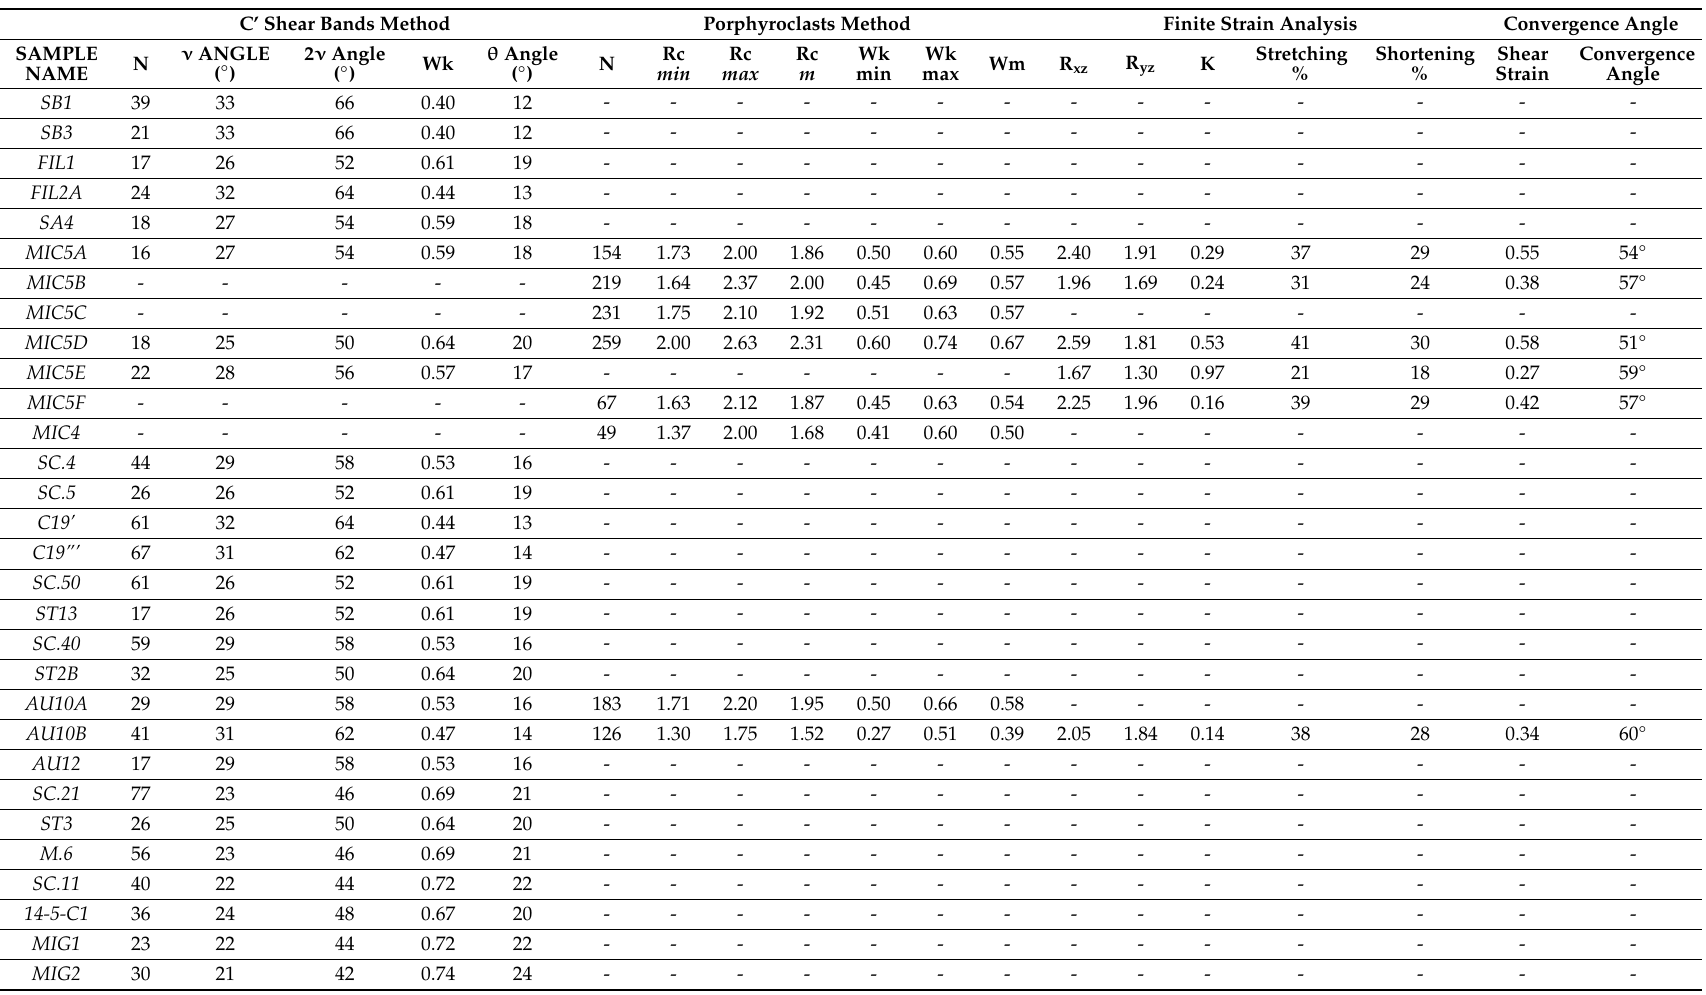
Table 1. Results of the kinematic vorticity and the finite strain calculations collected along the two study transects (see Figure 2 for samples location). C’ Shear Bands Method Porphyroclasts Method Finite Strain Analysis Convergence